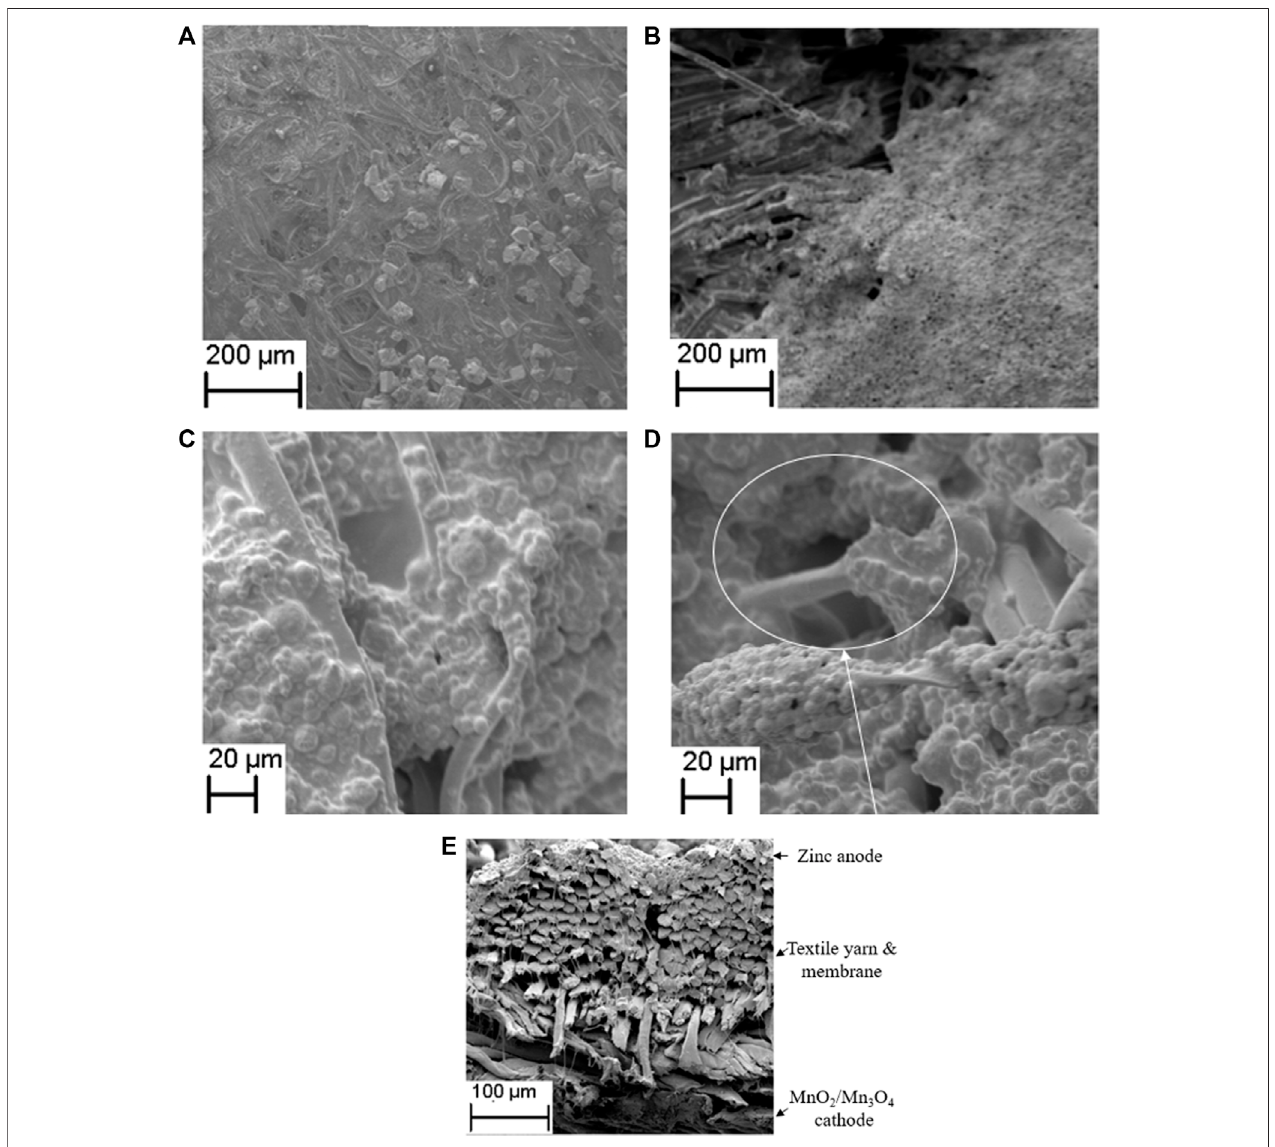
FIGURE3| TheSEMimageof (A) PlanviewoftheMnO 2 cathodeontextile. (B) PlanviewoftheMn 3 O 4 cathodeontextile. (C) Zincanodeontextile. (D) Zincanode on textile without membrane. (E) cross-section view of textile ZIB with MnO 2 or Mn 3 O 4 cathode.